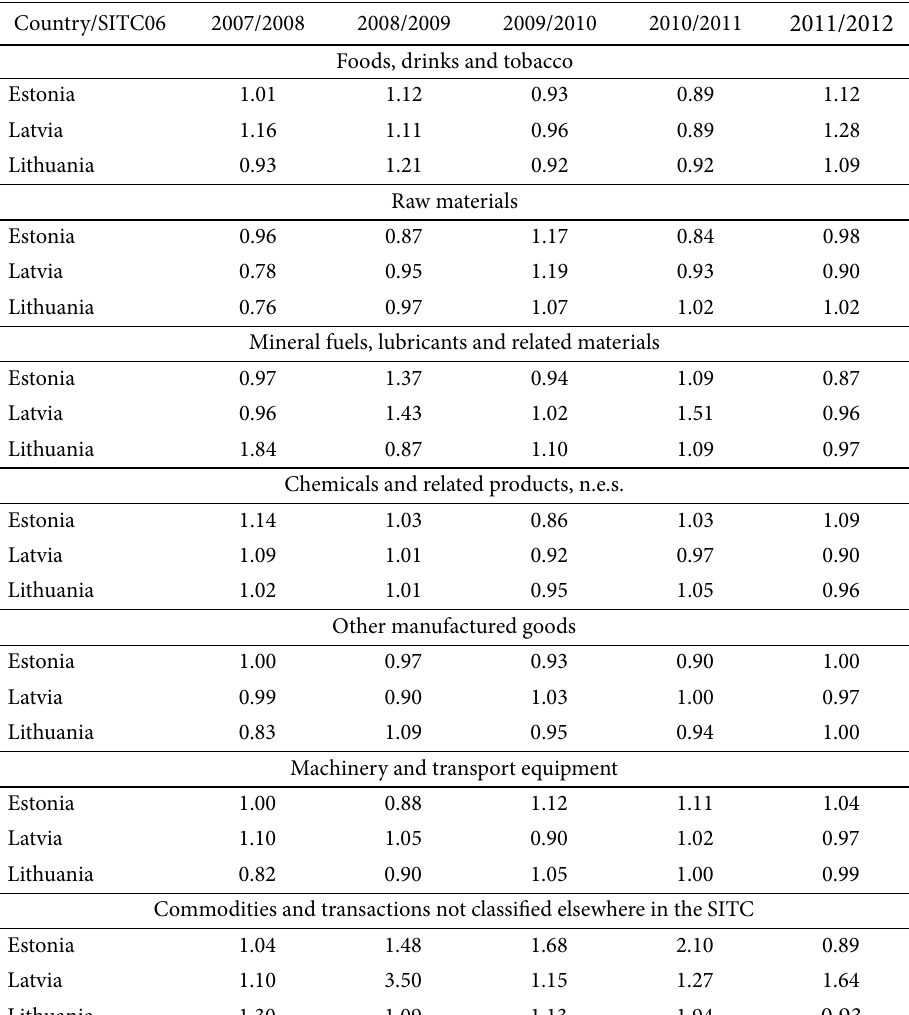
table 4. XCI index values calculated for the different groups of exported goods in the Baltic states Country/sItC06 Foods, drinks and